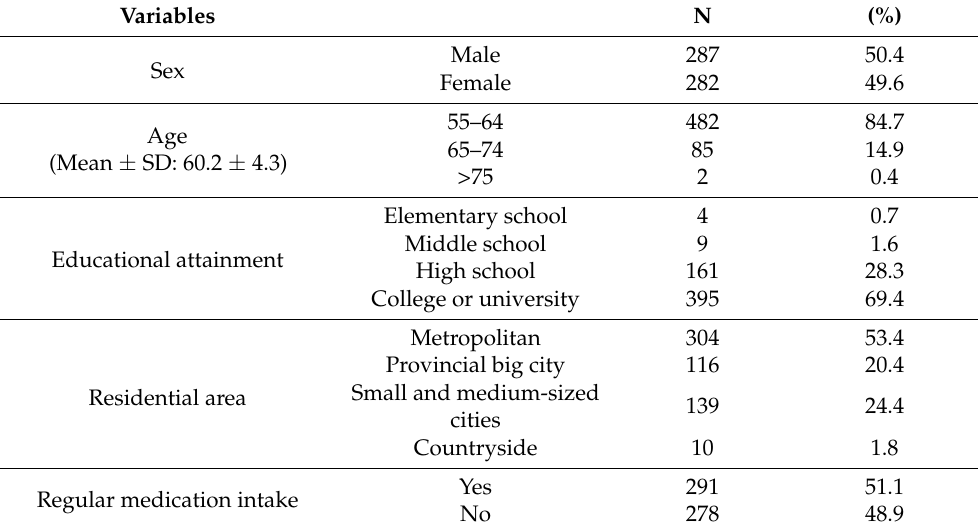
Table 1. General characteristics (N =